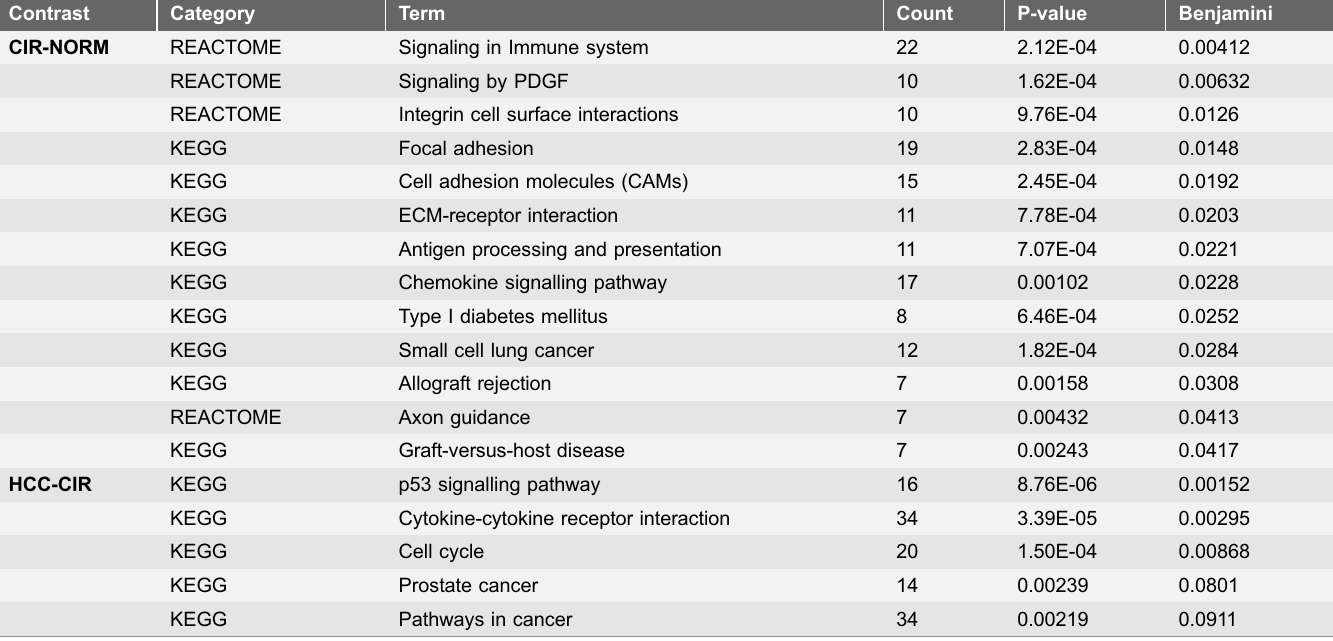
The functional enrichment has been performed for 484 and 776 DE genes respectively from CIR-NORM and HCC-CIR comparisons considering Reactome and KEGG pathways. The column ‘‘Count’’ reports the number of genes differentially expressed in the corresponding pathway; column ‘‘Benjamini’’ indicates the adjusted p